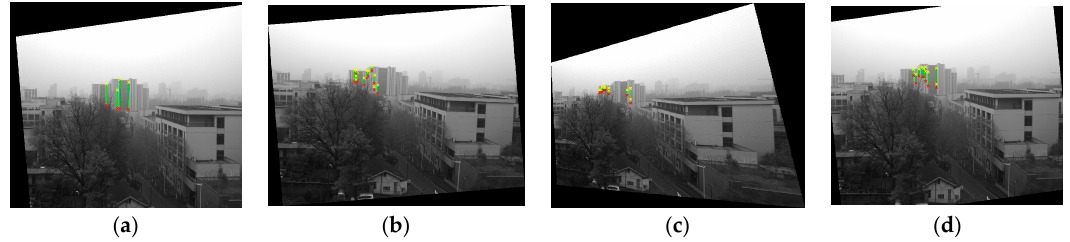
Figure 13. Images with lines detected after horizontal correction using the four methods. ( a ) Proposed method; ( b ) PCA method; ( c ) Hough method; ( d ) Radon method. Table 7. Comparison of results of the four methods.